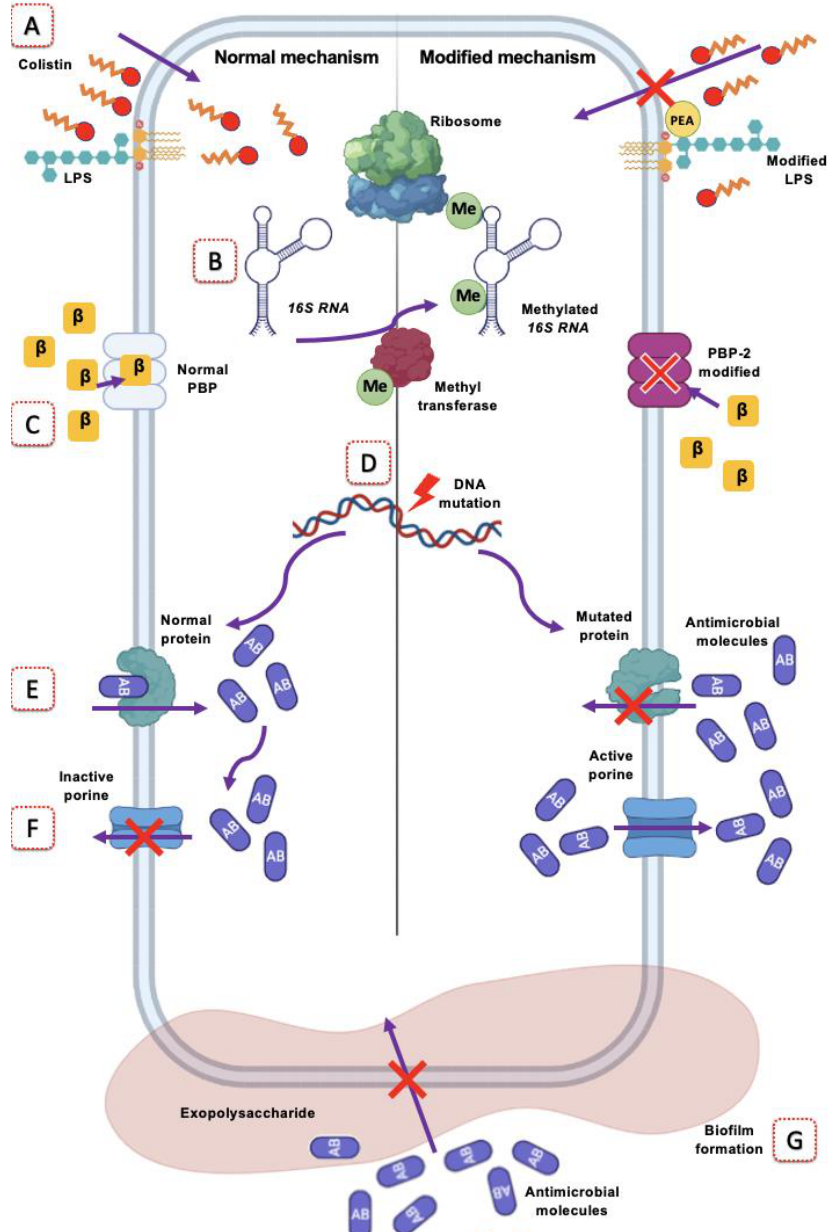
Figure 2. Mechanisms of antimicrobial resistance mediated by target site modification. In A. bau- mannii, the mechanisms it can use to be resistant to antimicrobials are: ( A ) Addition of phosphoeth- anolamine (PEA) to the lipopolysaccharide (LPS) molecule that confers resistance to colistin; ( B ) Methylation (Me) of 16S RNA mediated by methyltransferase, which prevents action with the anti- microbial; ( C ) The modification of penicillin-binding protein (PBP) to PBP-2A, which has a low af- finity for β - lactams (β); ( D ) Spontaneous mutations in DNA causing antimicrobial receptor or anti- microbial recognition (AB) proteins to be modified and fail to perform their function; ( E ) The protein to which the antimicrobial binds is modified; therefore, the antimicrobial cannot interact with the protein. ( F ) The antimicrobial inside the bacterium accumulates causing the death of the bacterium by an excess; through the use of efflux pumps, the bacterium can expel the antimicrobial. ( G ) The production of exopolysaccharide and the subsequent formation of biofilm prevents the contact of some families of antimicrobials with the bacterial structure, which generates resistance. Created at BioRender.com accessed on 3 june 2022.